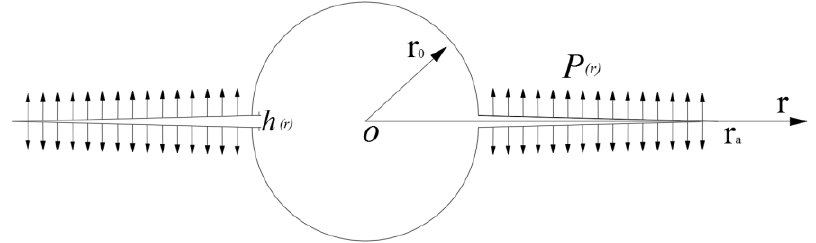
Figure 10. Dynamic propagation model of planar wedge cracks in infinite rock mass.